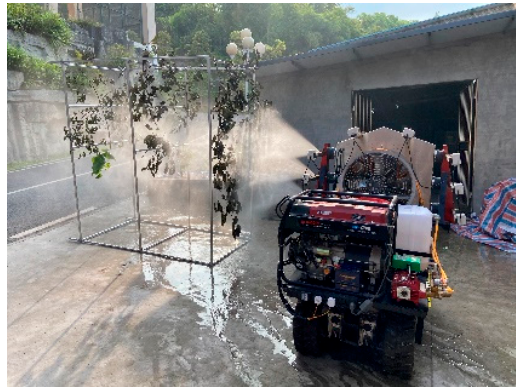
Figure 11. Test site.